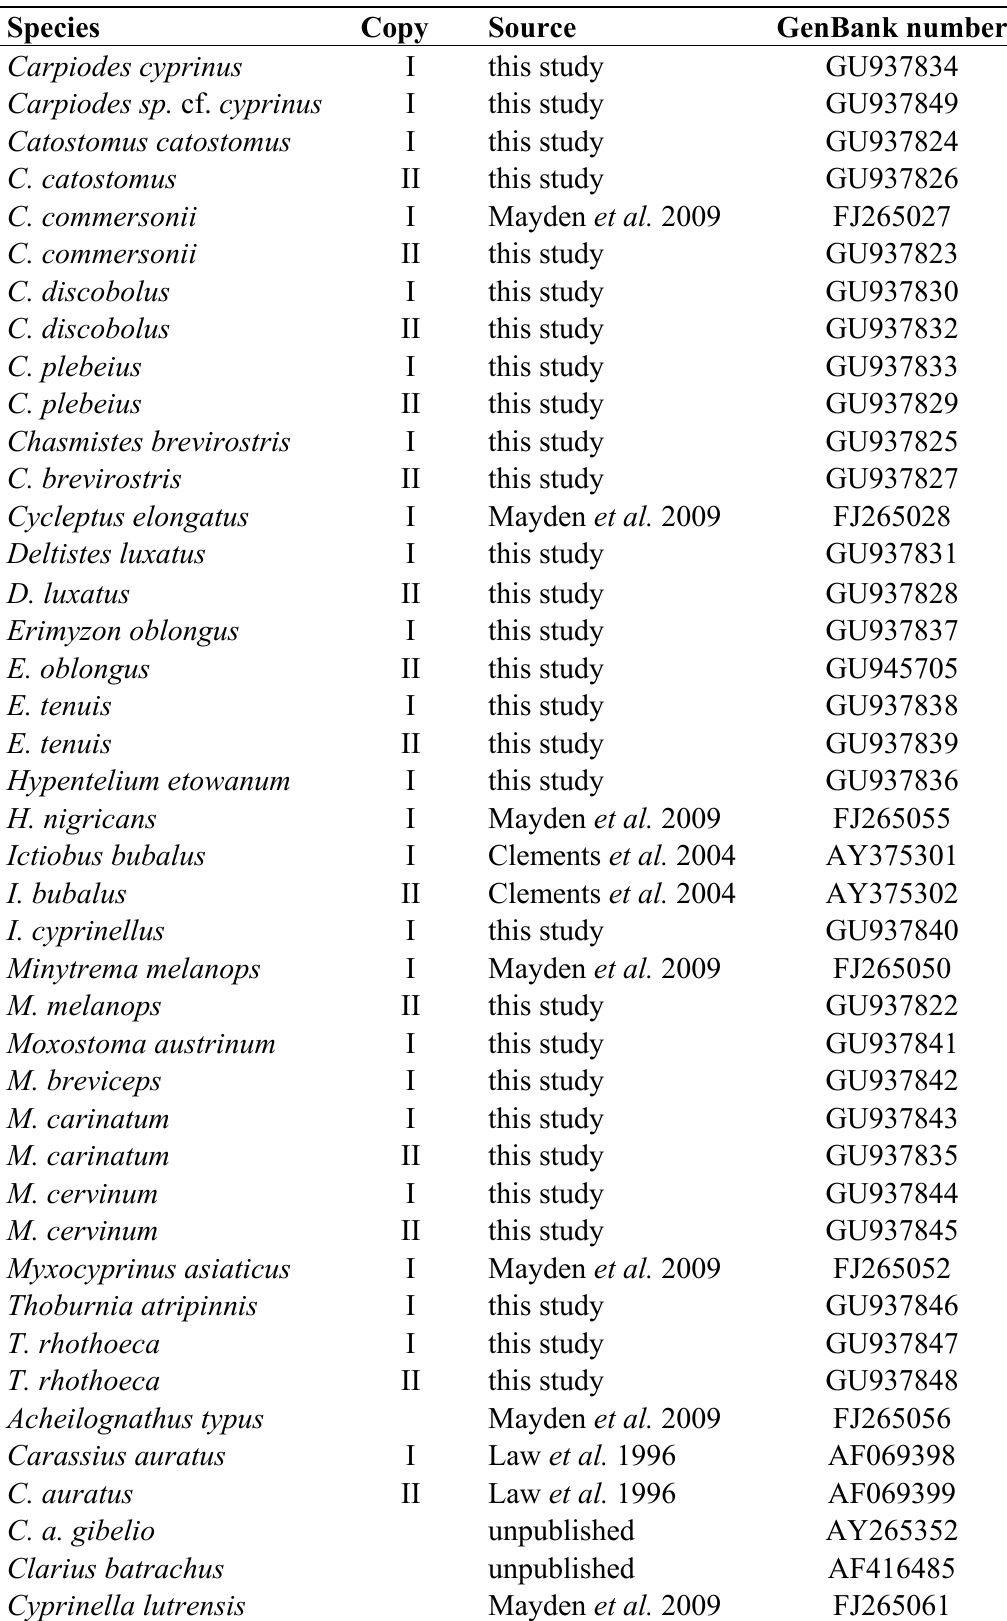
Table 1. List of species used in the comparative and phylogenetic analysis of catostomid GH